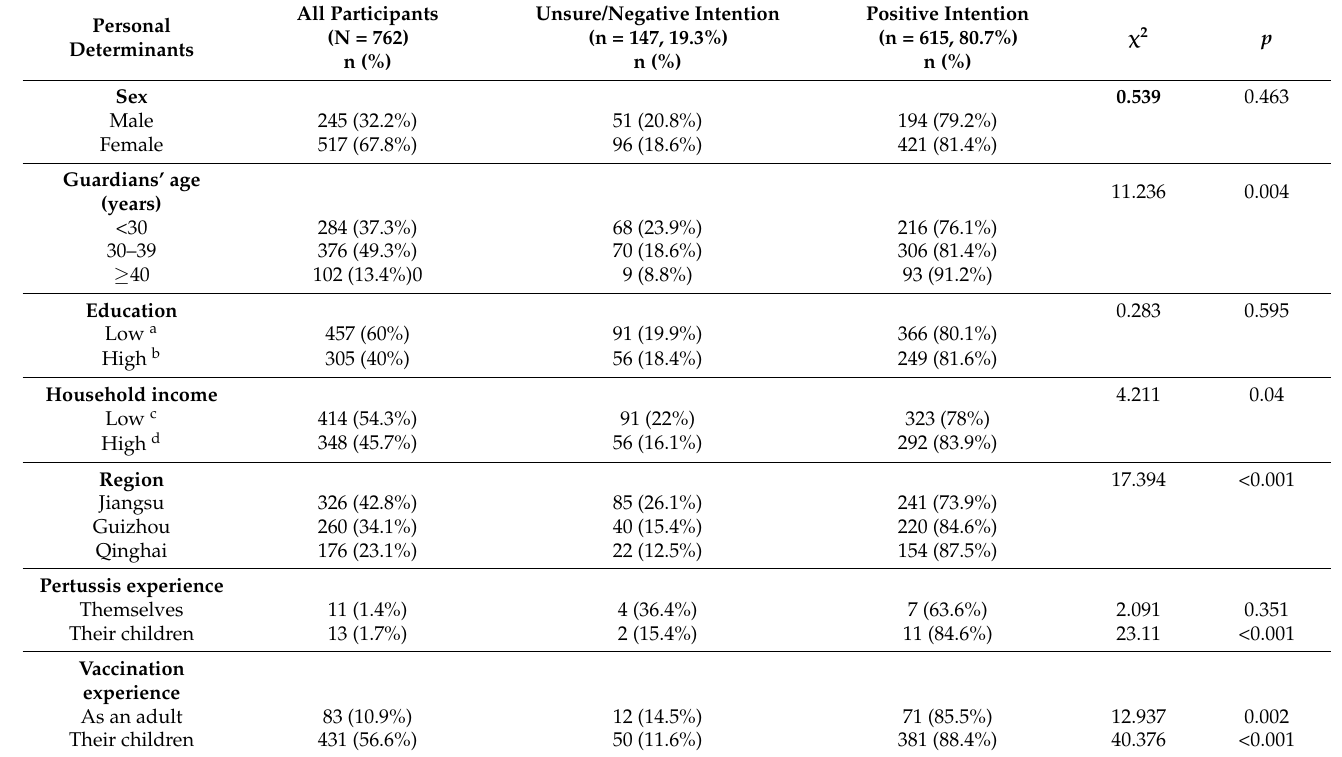
Table 1. Characteristics of guardians by intention to accept a pertussis cocooning vaccination (N =